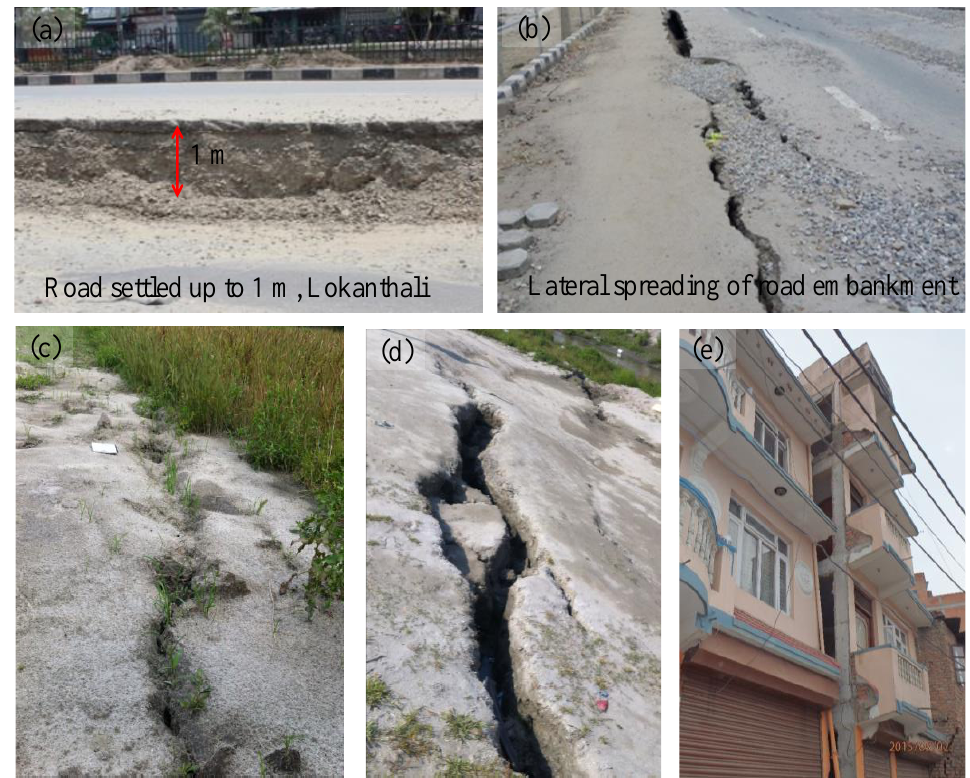
Figure 2. Ground liquefaction, settlement, and ground fissures: ( a ) road settlement at Lokanthali, Bhaktpur; ( b ) lateral spreading of road embankment, Lalitpur; ( c ) liquefaction in Bungamati, Lalitpur; ( d ) liquefaction-induced fissures in Mulpani, and ( e ) tilted building due to adjacent ground settlement during the 2015 Gorkha, Nepal, earthquake.